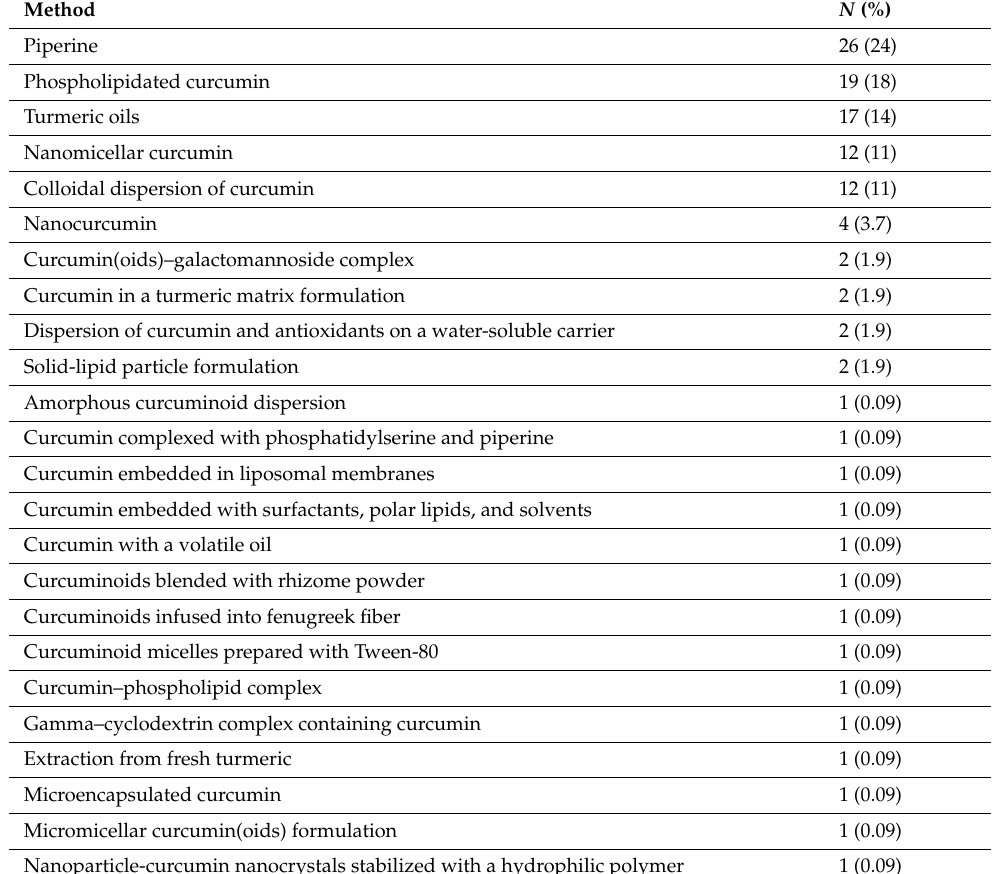
Table 3. Methods used to enhance the oral bioavailability of curcuminoids in analyzed trials ( N =